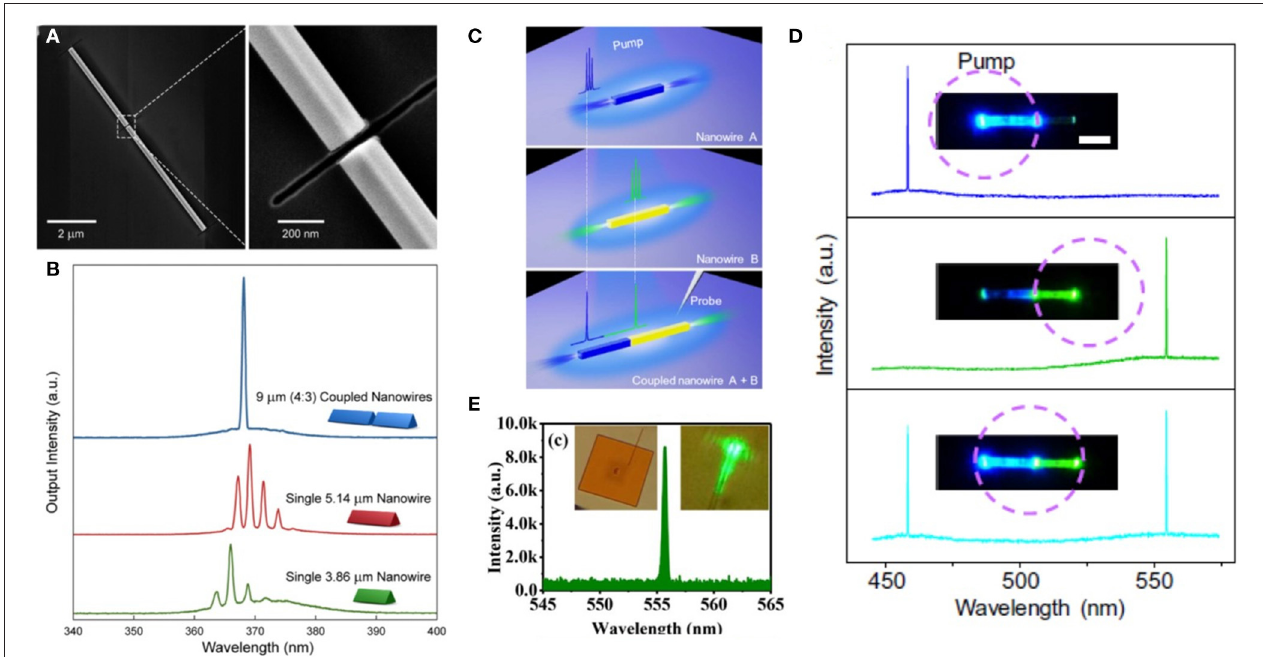
FIGURE 9 | (A) SEM images of the axially coupled GaN nanowires on silicon substrate. Scale bar: 2 µ m (left panel) and 200nm (right panel). (B) Lasing spectra from single GaN nanowire with length 3.86 µ m (green line), 5.14 µ m (red line), and coupled nanowires (blue line). (C) Sketch of the multimode lasing from separate A and B nanowires (top and middle) and dual-color single-mode lasing from axially coupled A + B nanowire cavities (bottom). (D) Lasing emission spectra of the axially coupled heterogeneous nanowire cavities under excitation at different positions. Scale bar: 10 µ m. (E) Spectrum of the single-mode lasing emission at a pump density of 12 µ J cm − 2 . Inset: optical microscope image and fluorescent image of the nanowire above the lasing threshold. (A,B) Reproduced with permission. Gao et al. (2013) Copyright 2012, National Academy of Sciences. (C,D) Reproduced with permission. Zhang C. et al. (2017) Copyright 2017, American Association for the Advancement of Science. (E) Reproduced with permission. Wang et al. (2016) Copyright 2016, Optical Society of